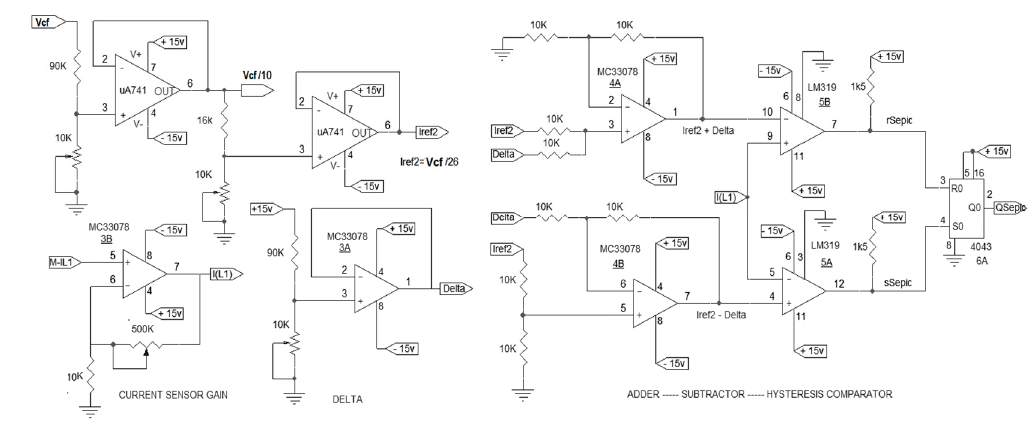
Figure 15. Sepic converter power stage.